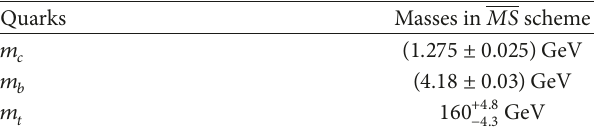
Table 2: The values of quark masses in 𝑀𝑆 scheme [9]. Quarks Masses in 𝑀𝑆 scheme